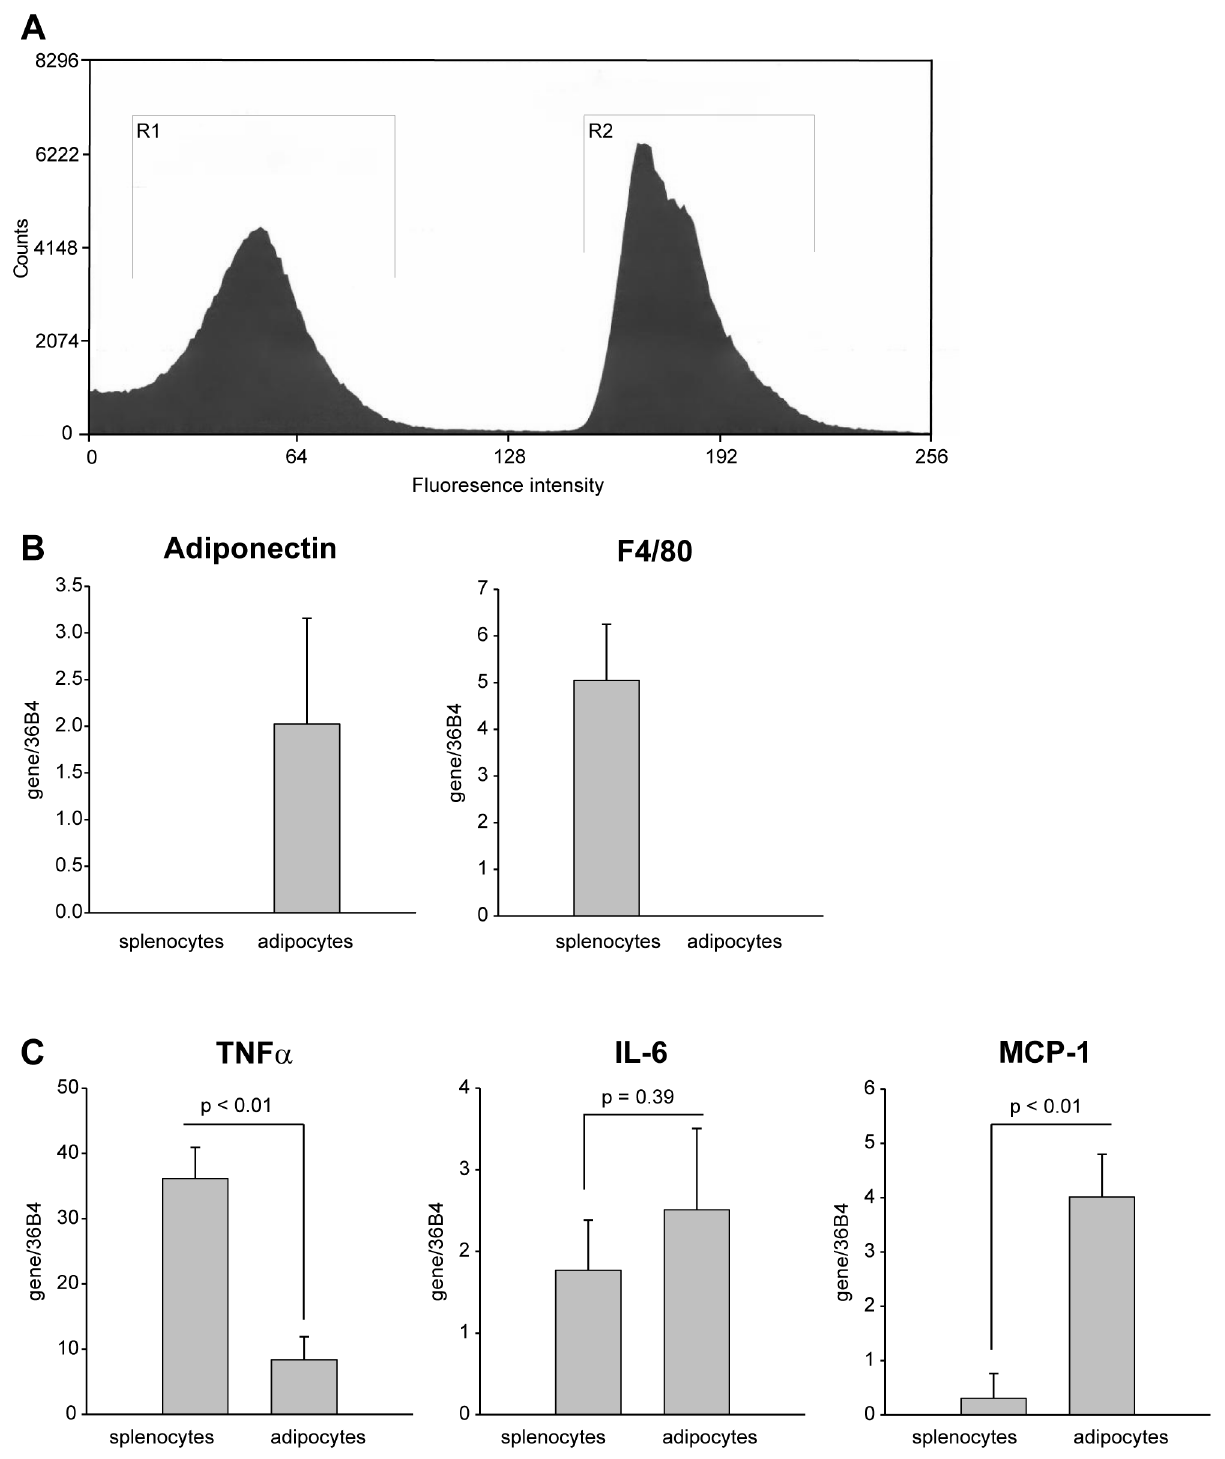
Figure 3. Splenocytes and adipocytes differentially express pro-inflammatory markers. Differentiated 3T3-L1 adipocytes were co- cultured in direct contact with GFP-expressing murine splenocytes and activated by incubation with LPS (1 m g/mL) for 24 h. Cells were sorted for GFP-positive (splenocyte) and negative (adipocyte) cells by FACS. (A) Representative FACS is shown, with GFP-negative cells gated in R1 and GFP- positive cells gated in R2. (B) Quantitative real-time PCR (qRT-PCR) was used to measure adiponectin and F4/80 expression, specific markers for adipocytes and splenocytes, respectively, to confirm efficiency of cell sorting. (C) TNF a , IL-6 and MCP-1 mRNA expression levels were quantified by qRT-PCR in splenocytes and adipocytes following cell sorting to distinguish individual cytokine expression patterns. All qRT-PCR values were normalized to values obtained for 36B4, a ribosomal 60S subunit protein. Experimental points were measured in duplicate (B and C) for calculation of means and standard deviations. In (C), statistical significance of differing secretion levels between splenocytes and adipocytes was determined by an unpaired two-tailed Student’s t-test. A significant effect was accepted when p , 0.05. doi:10.1371/journal.pone.0077306.g003 PLOS ONE |